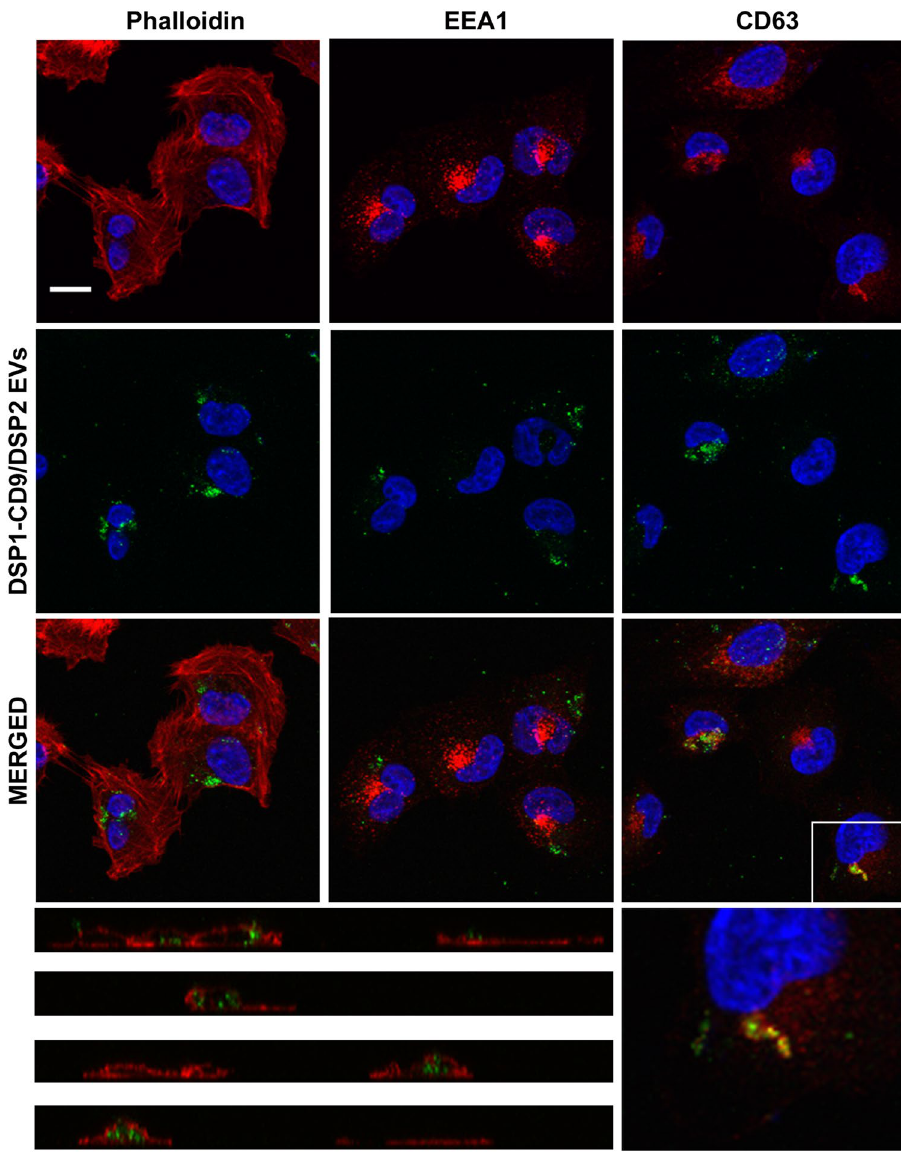
Figure 6. DSP1-CD9/DSP2 EVs uptake detected by fluorescence confocal microscopy. SUM159 target cells were incubated with DSP1-CD9/DSP2 EVs isolated by ultracentrifugation. Cells were fixed and permebilized after 5 h of incubation with EVs. Samples were stained with Phalloidin-647, α EEA1 antibody or α CD63 (Tea 3/10) mAb. All samples were co-stained with DAPI and analysed in a confocal fluorescence microscope. A maximal projection of the central optical sections is shown. Below, a series of vertical sections of Phalloidin- stained samples are depicted, clearly showing the intracellular localization of uptaken EVs. On the right, a zoomed image in which colocalization of EVs with CD63 labelling is demonstrated on a single confocal plane. Bar = 10 μ